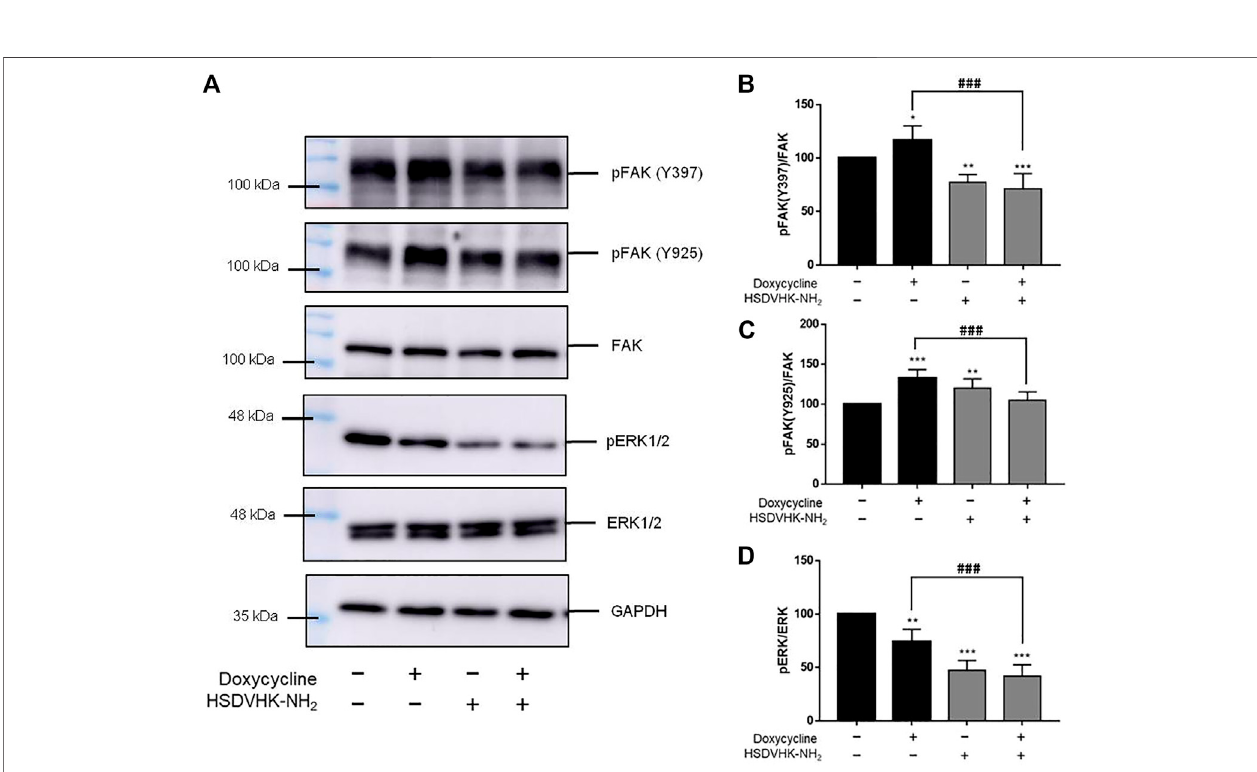
FIGURE3 | Blockage ofintegrin α v β 3activity inhibits doxycycline-induced signal transduction inbreast cancerMDA-MB-231 cells. (A) Cells were pre-treated with HSDVHK-NH 2 (10 µM) for 24 h, then treated with doxycycline (60 µM) for 24 h. Cells were harvested and protein was extracted for Western blotting analysis of pFAK (Y397), pFAK (Y925), FAK, pERK1/2, and total ERK1/2. The HSDVHK-NH 2 compound reduced doxycycline-induced phosphorylation of Y397 (B) , Y925 (C) , and pERK1/2 (D) . Numbers of independent studies ( n ) = 3. ANOVA was used to assess statistical signi fi cance. * p < 0.05, ** p < 0.01, *** p < 0.001, compared to the untreated control. ### p < 0.001, compared to doxycycline alone.